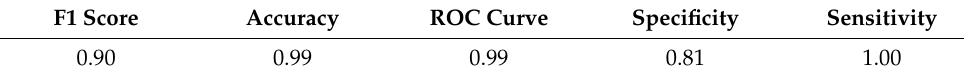
Table 7. Key parameters used in support vector machine.